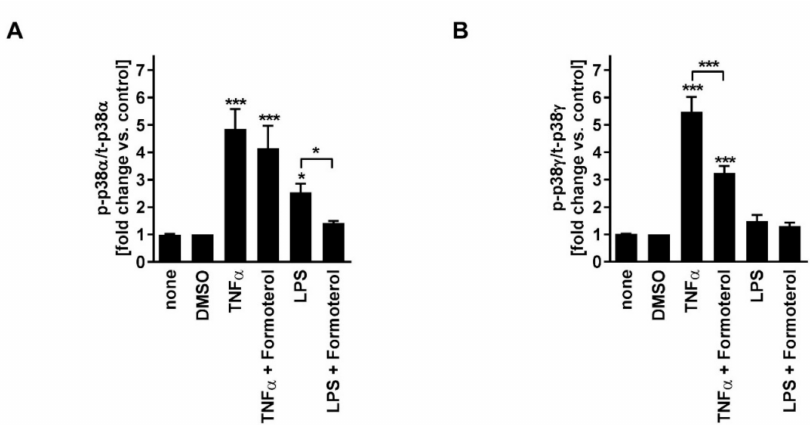
Figure3. Formoterolreducestheactivityofdi ff erentp38MAPKisoformsdependingontheinflammatory stimulus in HASMCs of COPD subjects. HASMCs ( n = 4) of COPD subjects were treated with formoterol (10 nM) or with DMSO (solvent control) two hours prior to stimulation with TNF α (20 ng / mL) or LPS (1 µ g / mL). After 15 min of incubation, levels of total and activated (T180 and Y182 phosphorylated) p38MAPK α ( A ) and of total and activated (T183 and Y185 phosphorylated) p38MAPK γ ( B ) were measured in cell lysates by ELISA. Data for phosphorylated proteins were normalized to the total levels and to the DMSO controls that were set to 1 ( = no induction of activation). Data are presented as mean ± SEM. One-way repeated-measures ANOVA with 95% CI: ( A , B ) p < 0.0001; post-hoc Bonferroni analyses: * p < 0.05; *** p < 0.001 vs. DMSO control or as